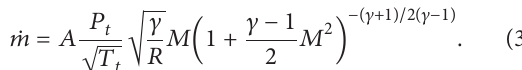
contours and isosurface are similar to those of the adiabatic case and are not shown for